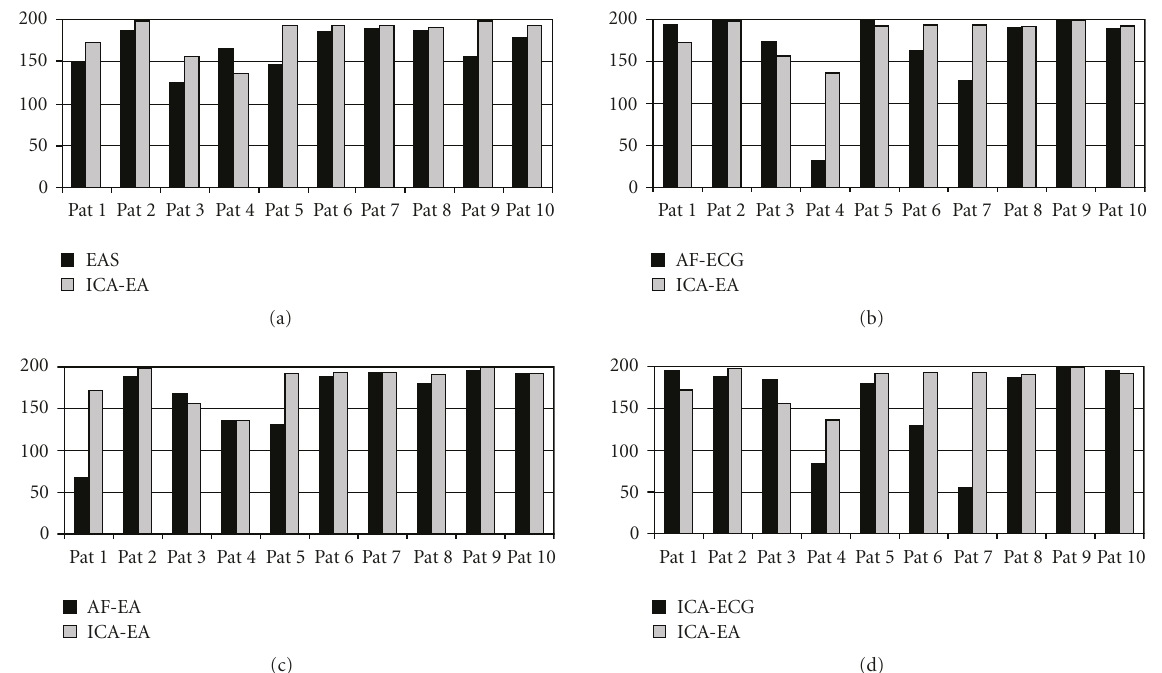
Figure 17: Comparison between the ICA-EA method and the four other algorithms: number of corrected peaks for each patient.